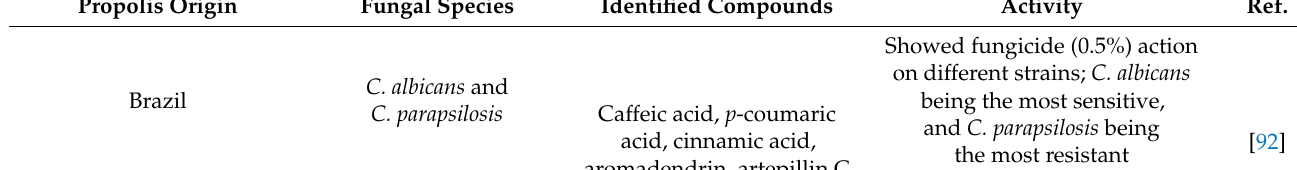
Table 9. Antifungal activity of diverse propolis and its chemical composition on different Candida strains. Propolis